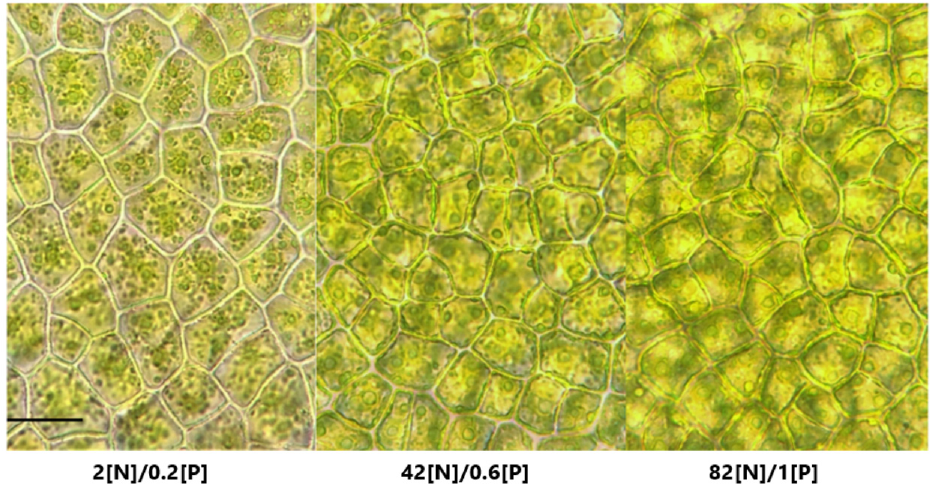
Figure 9. Superficial view of the blade of U. ohnoi subjected to the three different levels of nutrients (2N/0.2P, 42N/0.6P and 82N/1P). Scale bar = 25 µm.